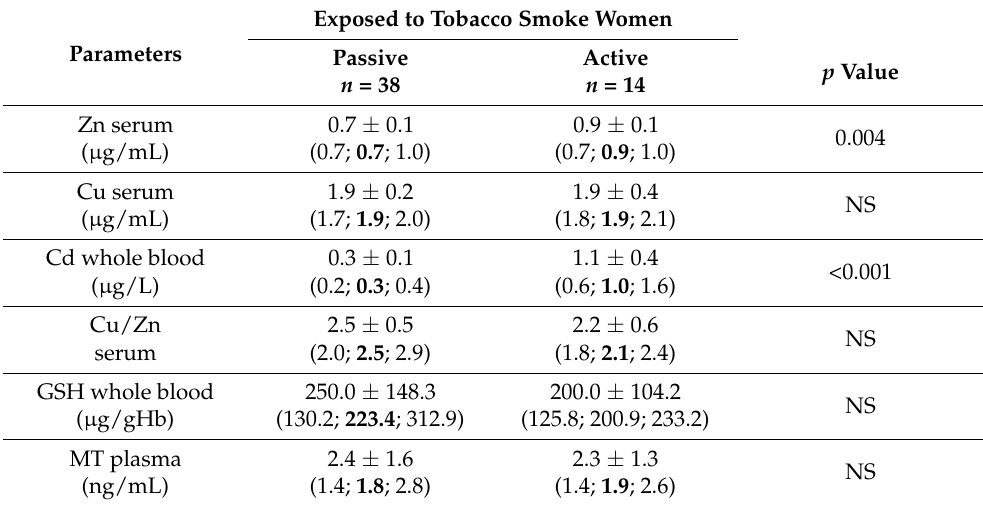
Table 5. Values of selected antioxidative parameters, and metals in studied